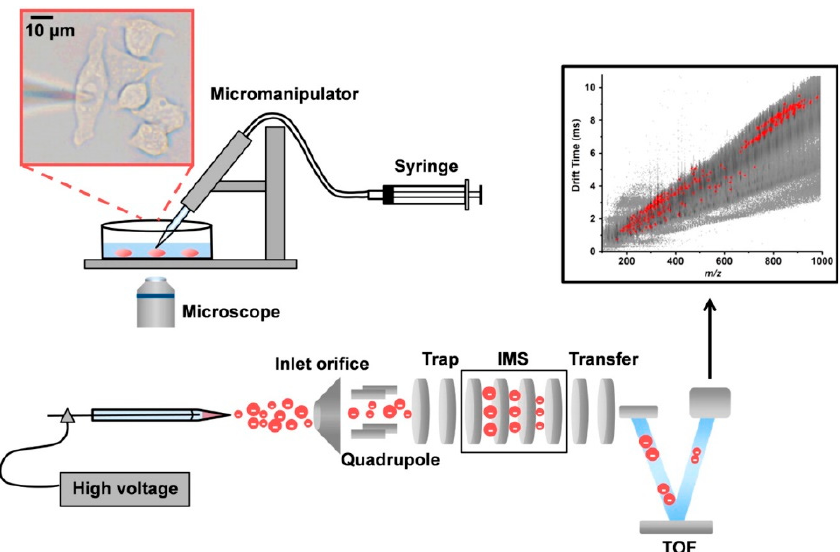
Figure 7. Schematic representation of experimental setup for single cell analysis using capillary microsampling ESI-ion mobility spectrometry (IMS)-MS. The pulled capillary is held by a micromanipulator and inserted into the cell. The cell content is then extracted with a syringe connected to the capillary. The inset shows a microscope image taken from an inverted microscope. After extraction, the capillary is filled electrospray solution, placed near the MS inlet, and subjected to a voltage to generate an electrospray. The resulting ions are separated by drift time (DT) ion mobility spectrometry (IMS) prior to MS analysis on a time of flight (TOF) MS. The resulting analytes are plotted by DT versus mass-to-charge ratio ( m/z ). Reprinted with permission from https://pubs.acs.org/doi/abs/10.1021/acs.analchem.5b02502 [52]. Further permissions related to the material excerpted should be directed to the American Chemical Society.